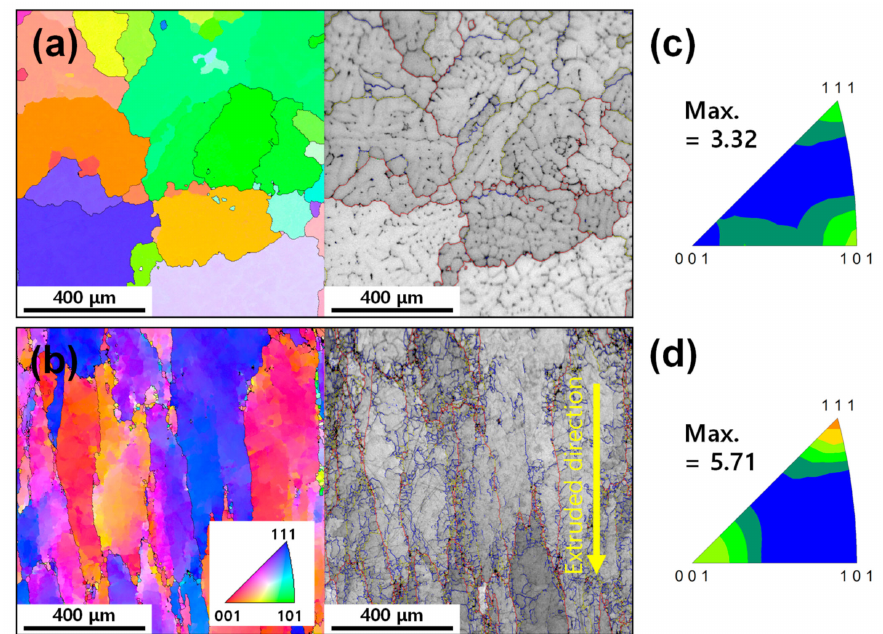
Figure 1. The inverse pole figure (IPF) maps and image quality maps overlaid with grain boundaries of the ( a ) as-cast and ( b ) extruded alloys. The inverse pole figures of the ( c ) as-cast and ( d ) extruded alloys. The maximum texture intensity in the inverse pole figures is in the unit of multiples of a random density ◦ ≤ θ < ◦ (MRD). Low-angle grain boundaries (2 5 ), intermediate-angle grain boundaries (5 ◦ ≤ θ and high-angle grain boundaries (15 ) are represented by blue, yellow and red colors, respectively. The inset in ( b ) shows the color code for the electron backscatter di ff raction (EBSD) scans of ( a ) and ( b ).